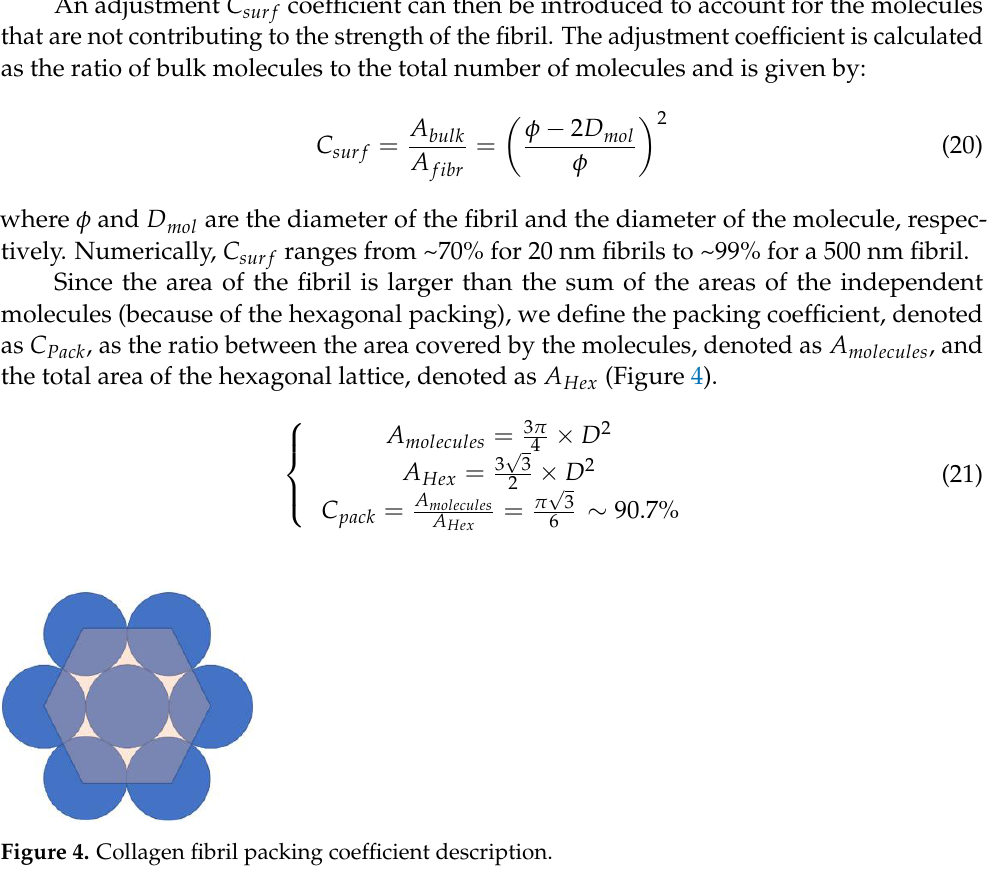
Figure 3. Beads’ displacement paths in the hexagonal collagen structure: ( a ) sliding bead position for lowest and highest energy states; ( b ) displacement paths for the sliding bead for the different coordination configurations.